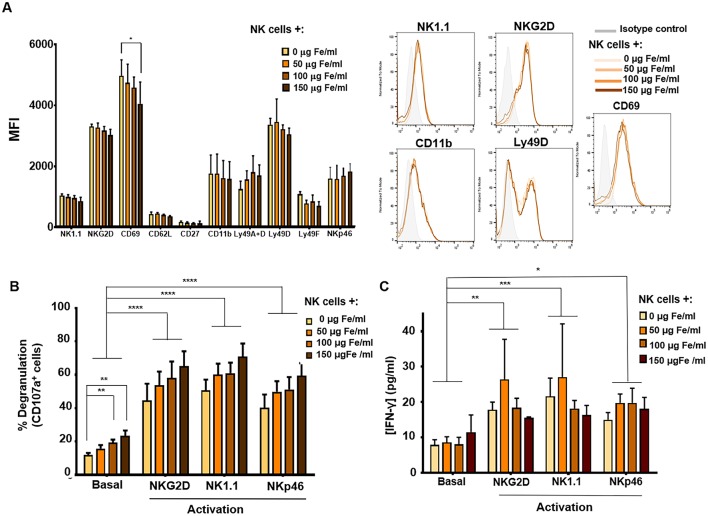
Phenotypic and functional analysis of murine NK cells after their association with MNPs. (A) Quantification (MFI, mean fluorescence intensity) of the expression of relevant cell-surface markers in murine NK cells after incubation with MNPs and representative histograms. (B) Degranulation capacity of murine NK cells after treatment with different concentrations of MNPs and after exposure to a variety of stimuli. (C) Quantification of IFN-γ production by murine NK cells after MNP treatment and exposure to a range of stimuli, measured by ELISA assay. The data (mean ± SD) are representative of three independent experiments, *p < 0.05, **p < 0.01, ***p < 0.001, ****p < 0.0001.